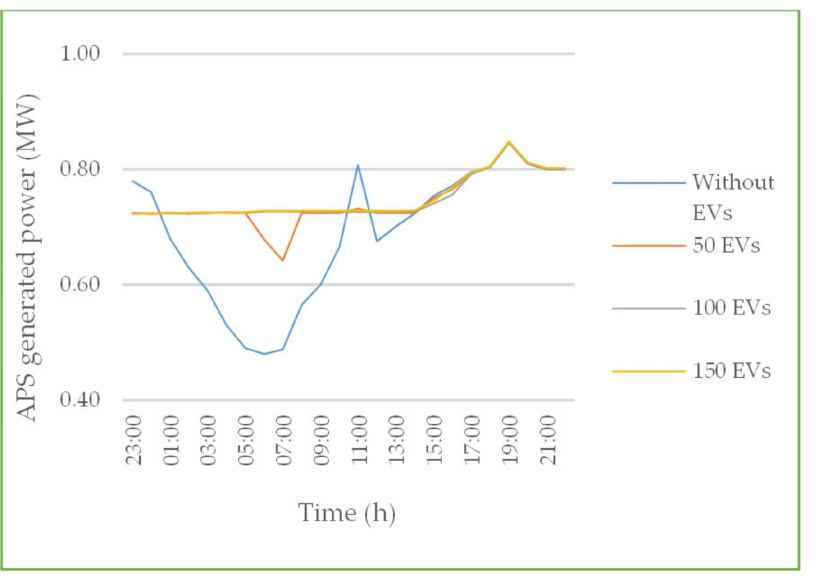
Figure 14. APS output required in the presence of a 140.0 kWp PV plant for test case 2 and